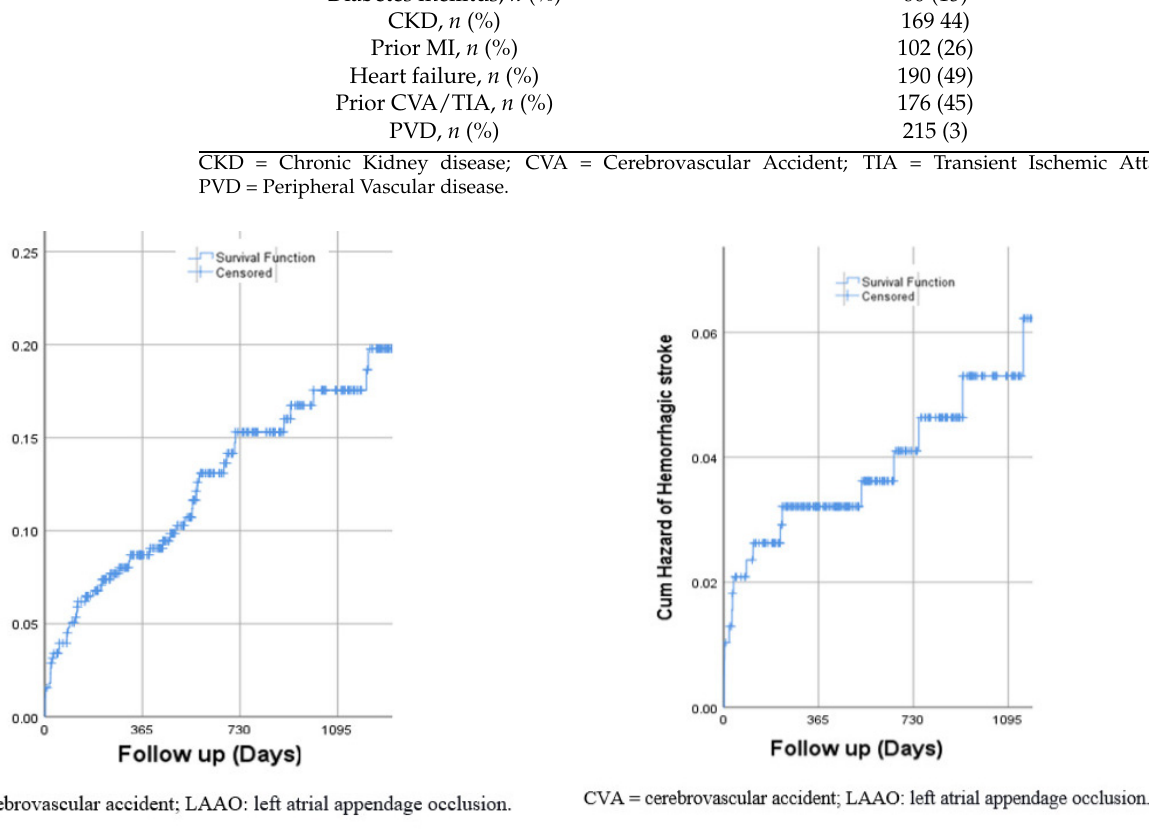
Figure 1. ( a ) Risk of ischemic CVA following LAAO; ( b ) Risk of hemorrhagic CVA following